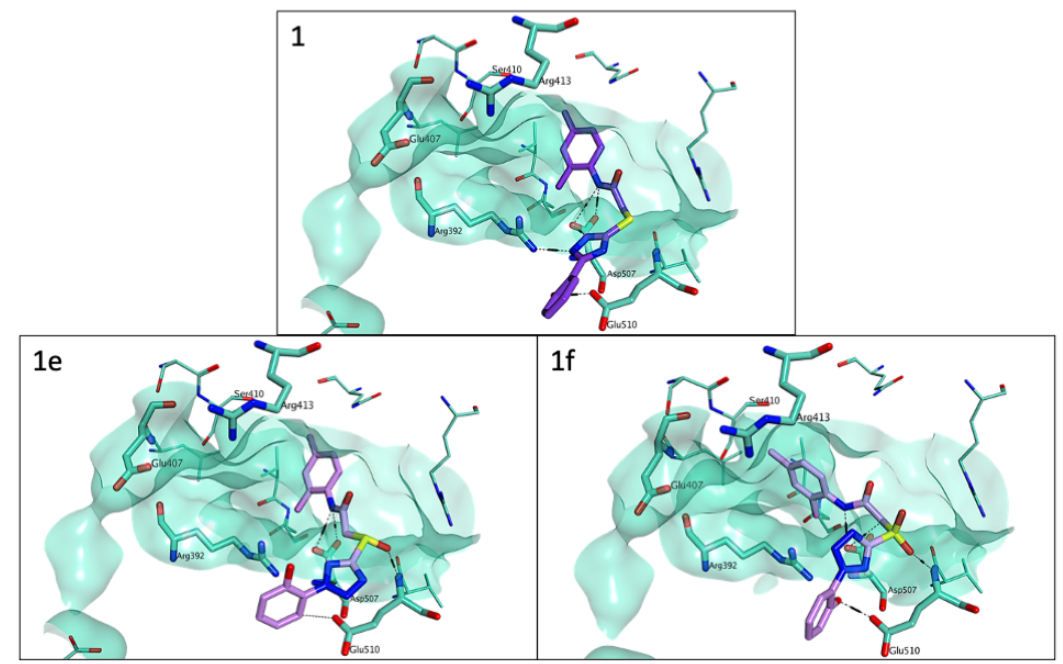
Figure 5. Proposed binding mode for 1 (carbon atoms in purple) and 1e , f (carbon atoms in lilac) to the human norovirus RdRp (PDB ID 4LQ3). The binding site area is represented as green molecular surface. Human norovirus RdRp is represented as green ribbon, with carbon atoms in green. Black dashed lines represent non-bonded interactions (e.g., hydrogen bonds, electrostatic interactions) between the ligand and the amino acid residues of the protein.